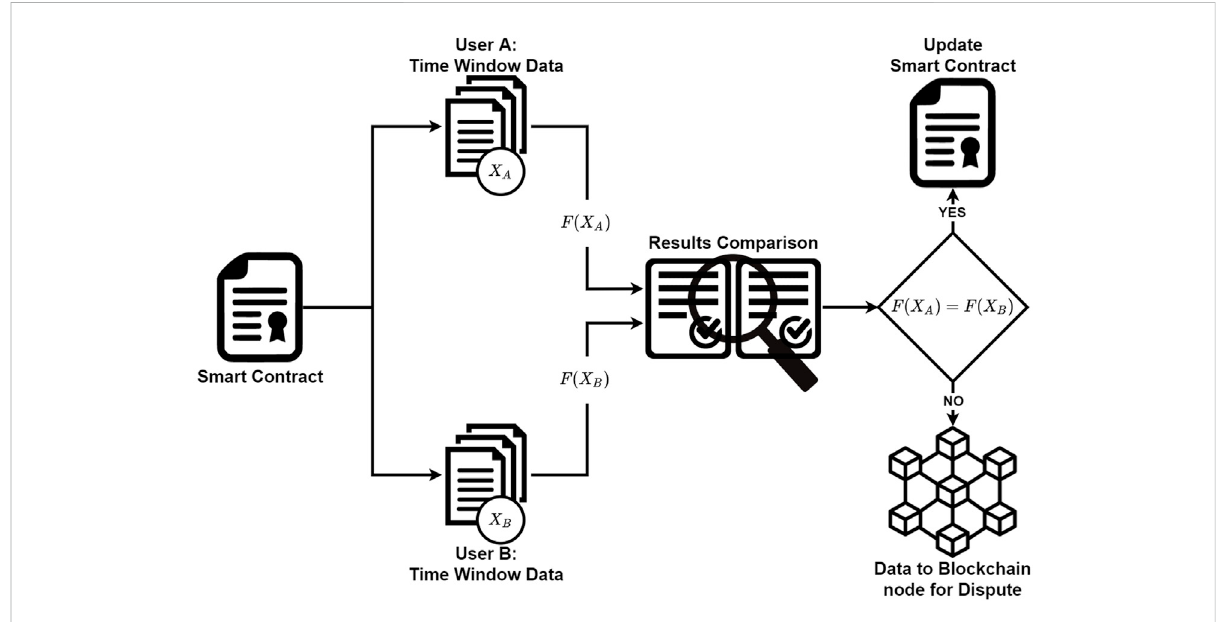
FIGURE 1 DIVERSITY off-chain execution for user A and B.